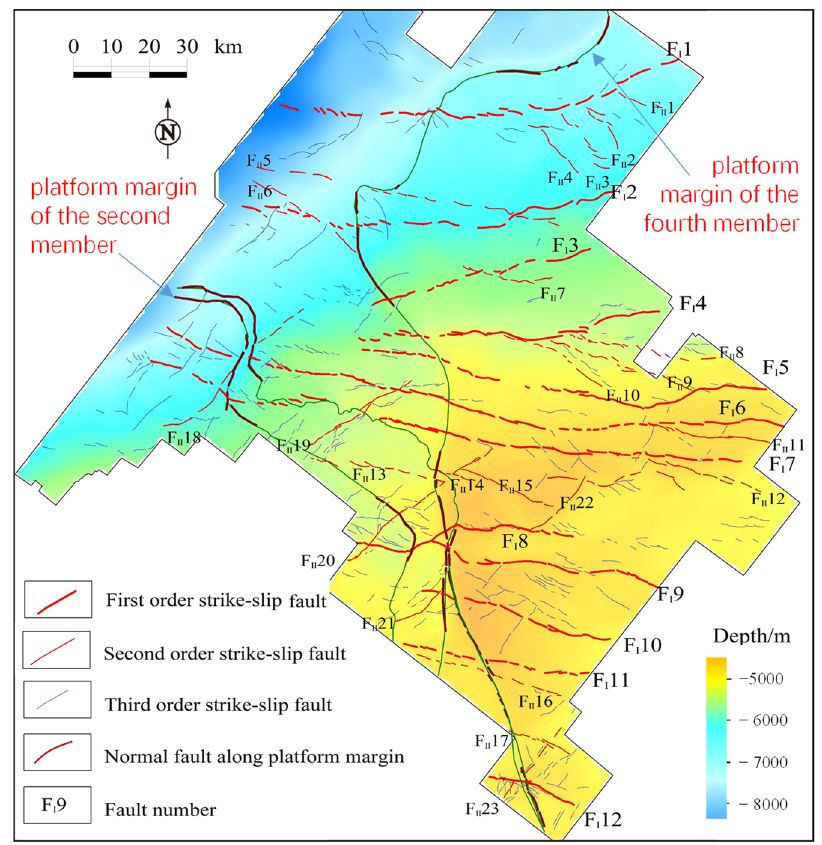
Figure 6. The strike ‐ slip fault system at the Ediacaran Dengying Formation in the central Sichuan Basin (the first order strike ‐ slip fault zone could extend out of the 3D area and offset across the Basin (the first order strike-slip fault zone could extend out of the 3D area and offset across the platform margin of the Dengying Formation; after reference [20]). platform margin of the Dengying Formation; after reference